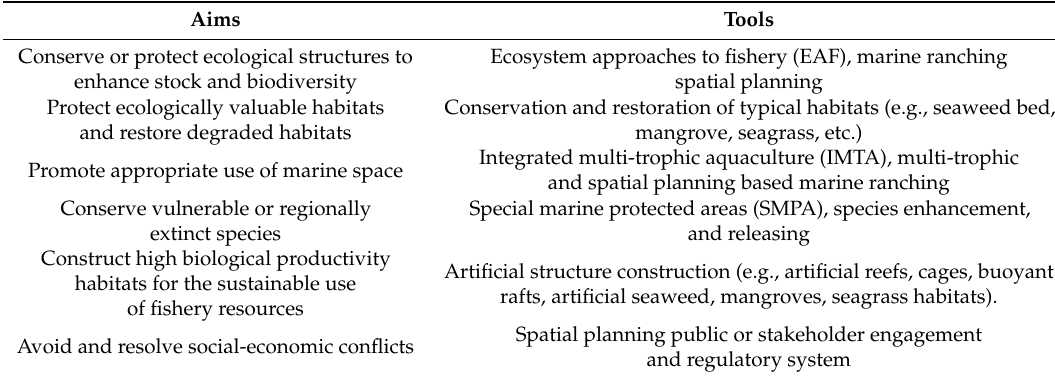
Table 1. Aims of and tools for marine